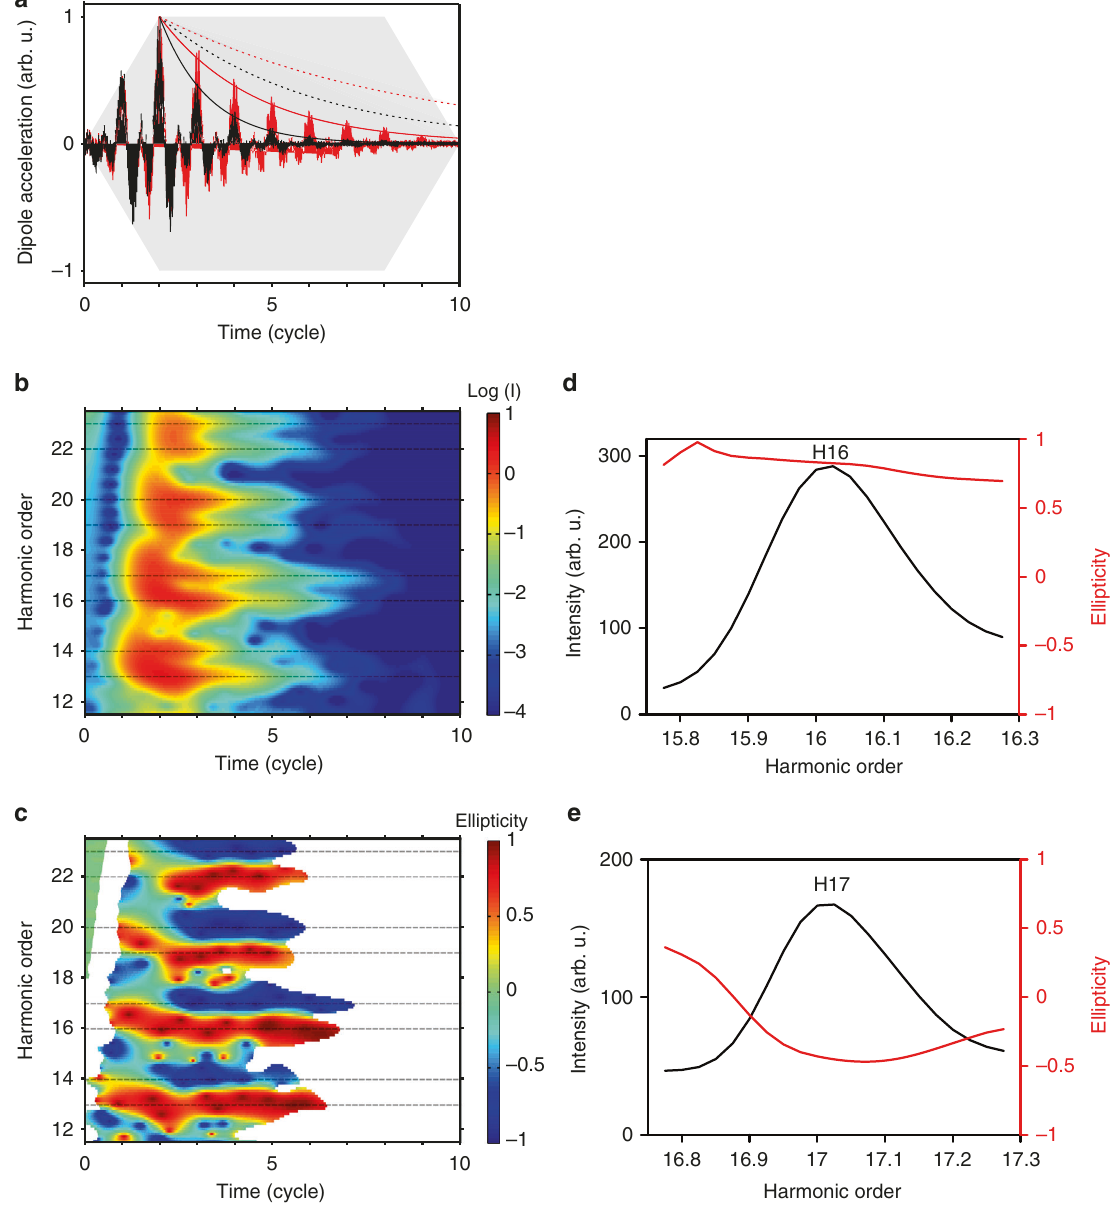
Fig. 2 Ionization effects in argon. a Dipole acceleration along the x axis calculated for trapezoidal pulses (shaded gray area) in argon at intensities I 0 = I ω = I = 8 × 10 13 (red) and 1.2 × 10 14 W/cm² (black) and their envelopes (exponential solid lines). At 1.2 × 10 14 W/cm², only the fi rst cycles contribute to the 2 ω emission due to strong ionization. We show for comparison the dipole envelopes calculated with a linearly-polarized IR pulse of same total energy I ω = 2 I 0 = 1.6 × 10 14 (red dashed line) and 2.4 × 10 14 W/cm² (black dotted line). b Time-frequency representation of the harmonic intensity, in logarithmic scale, for I = 1.2 × 10 14 W/cm², obtained after Gabor transformation of the dipole with a temporal Gaussian window of one- ω - cycle FWHM. c Time-frequency 0 representation of the harmonic ellipticity for I 0 = 1.2 × 10 14 W/cm². d , e Spectrum (black) and spectrally-resolved ellipticity (red) of harmonics 16 and 17 for I = 1.2 × 10 14 0